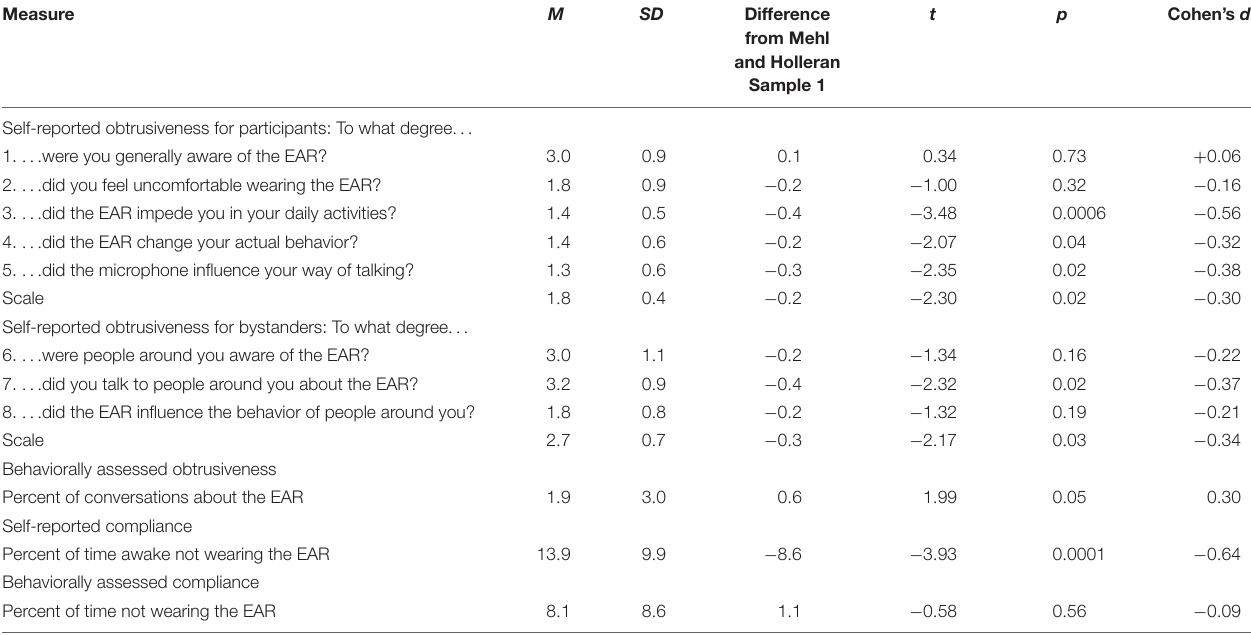
TABLE 1 | Self-reported and behaviorally assessed EAR obstrusiveness and compliance in the all-party consent compliant study (the present study), and comparison with the one-party consent compliant study of Mehl and Holleran (2007). Measure M SD Difference